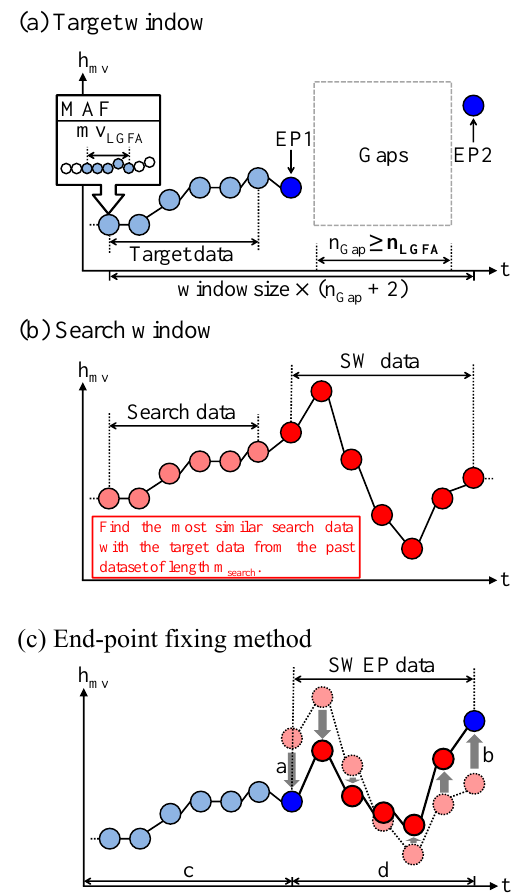
Figure 6: Schematic sketch of LGFA of the gap filling algorithm: (a) target window Figure 6. Schematic sketch of LGFA of the gap-filling algorithm: (blue tone), (b) search window (red tone), (c) end point fixing method. The water-level data are represented as circles and a gray dotted box indicates the location of gaps. (a) target window (blue tone), (b) search window (red tone), (c) end- MAF stands for Moving Average Filter. The moving averaged data are referred to as h mv . point fixing method. The water level data are represented as circles, and a gray dotted box indicates the location of gaps. MAF stands for moving average filter. The moving-averaged data are referred to as h mv